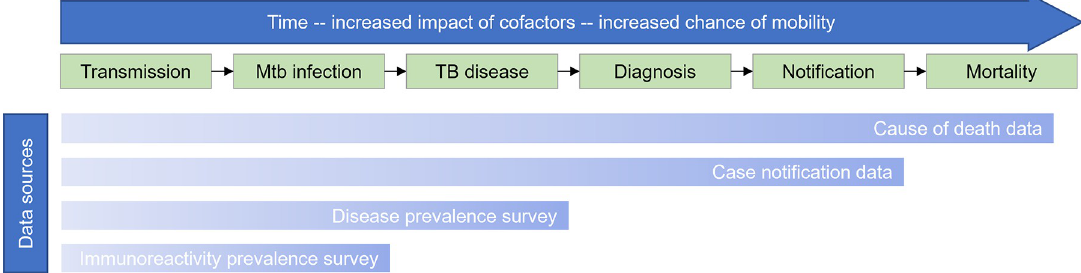
Fig 1. Simplified diagram of the causal stages between TB transmission, case notification and mortality. Data sources (bottom) may capture more proximal or distal stages of the process. As methods capture later stages, it becomes increasingly challenging to draw inferences about the original causative transmission